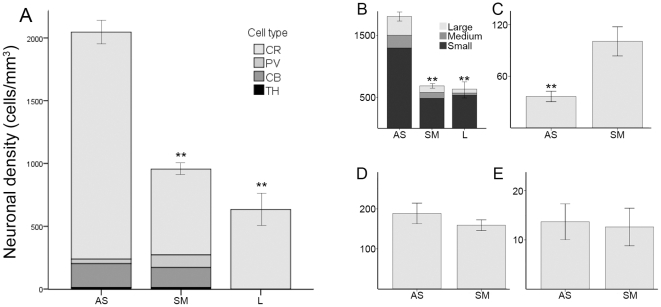
Neuronal density of the various groups of neurons in the functional territories of the striatum.A, stack bar graph showing the global interneuronal density. The colors of the stacks indicate different chemospecific subsets of neurons. B, stack bar showing the density (cells/mm3) of large, medium and small CR-ir interneurons. C–E, neuronal density (cells/mm3) of the PV-, CB- and TH-ir neurons, respectively. Error bars indicate the SEM. **, P<0.01. AS, associative; L, limbic; SM, sensorimotor.